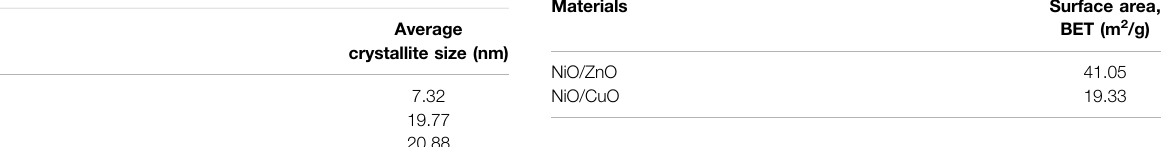
TABLE 1 | Average crystallite size of NiO, NiO/ZnO, and NiO/CuO obtained from the Scherrer equation. Materials